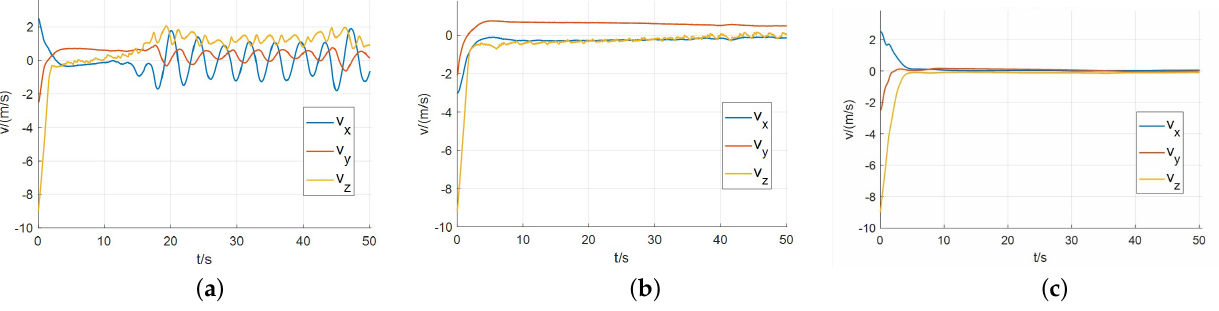
Figure 6. The curves of velocity deviation in velocity tracking experiments. ( a ) DDPG. ( b ) TD3. ( c ) SAC.